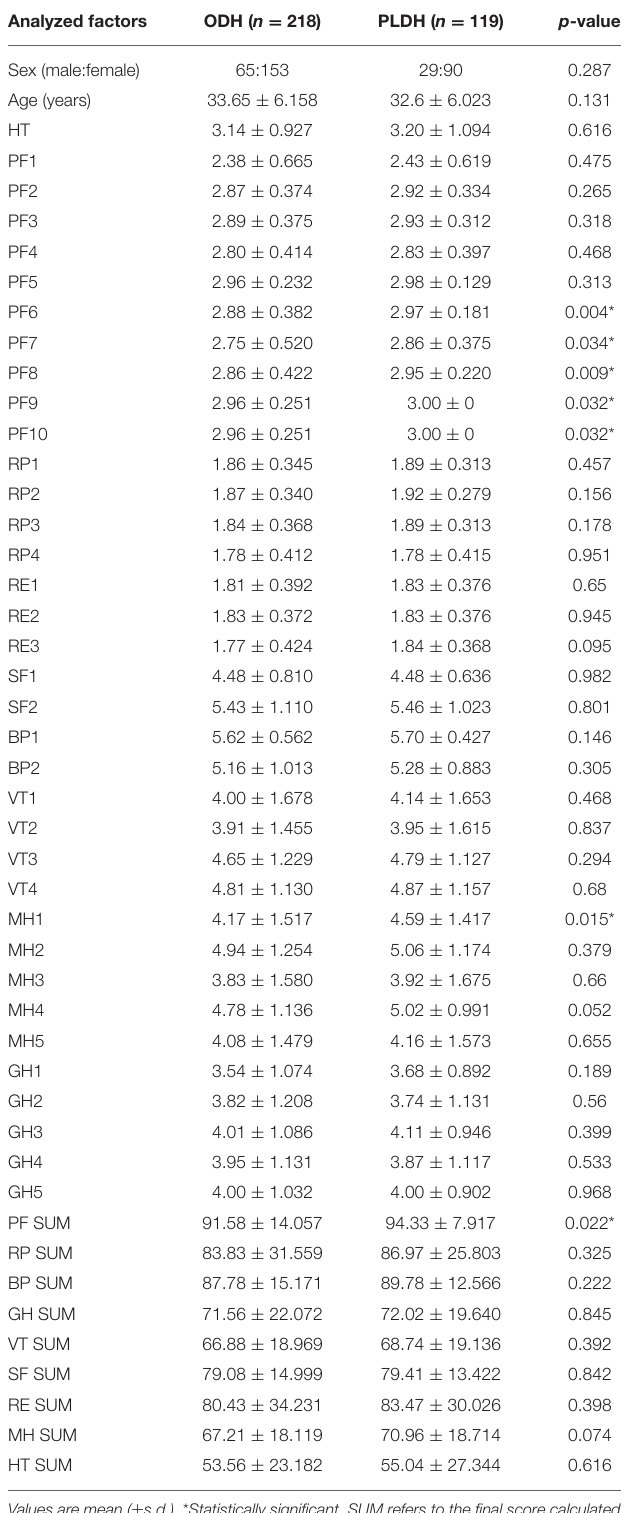
TABLE 3 | The results of SF-36 questionnaire of donors. Analyzed